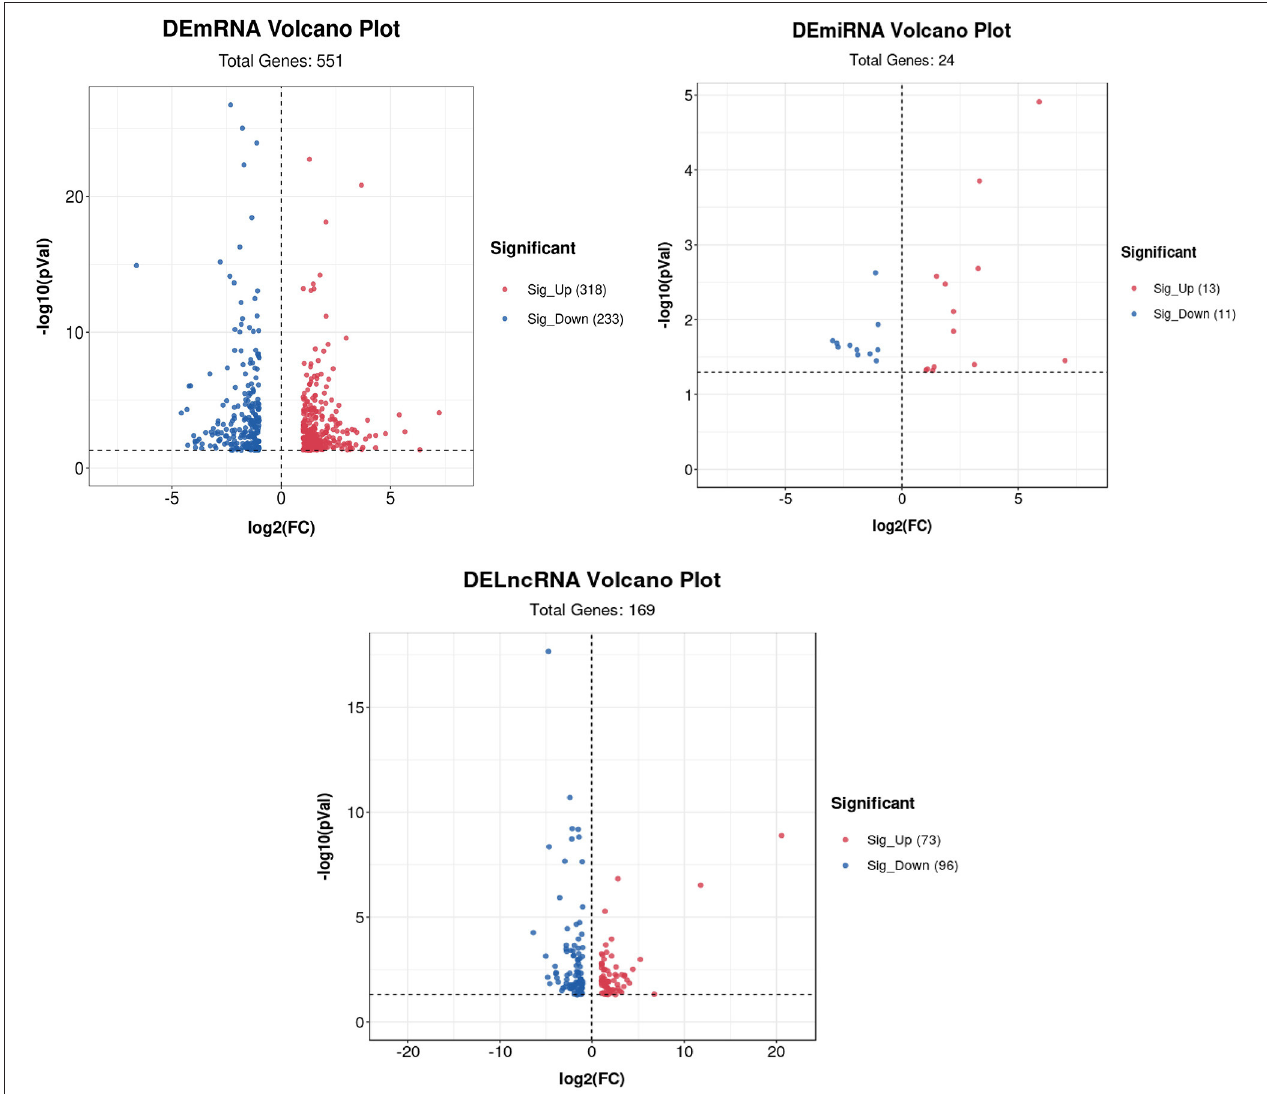
FIGURE 5 | Volcano plot of DEmRNAs, DElncRNAs, and DEmiRNAs. Red represents upregulated genes, and blue represents downregulated genes.